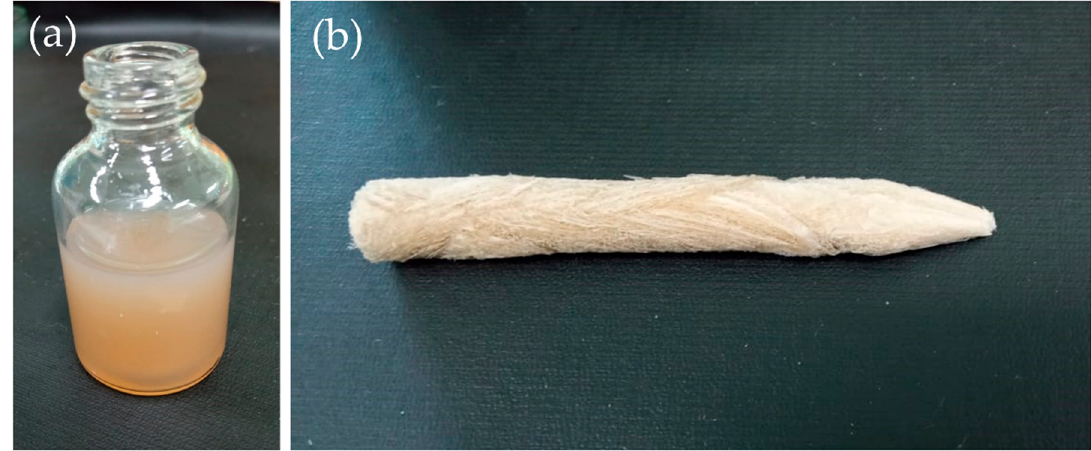
Figure 1. Photograph of aerogel CNC/CNF mixture ( a ) suspension; ( b ) aerogel.